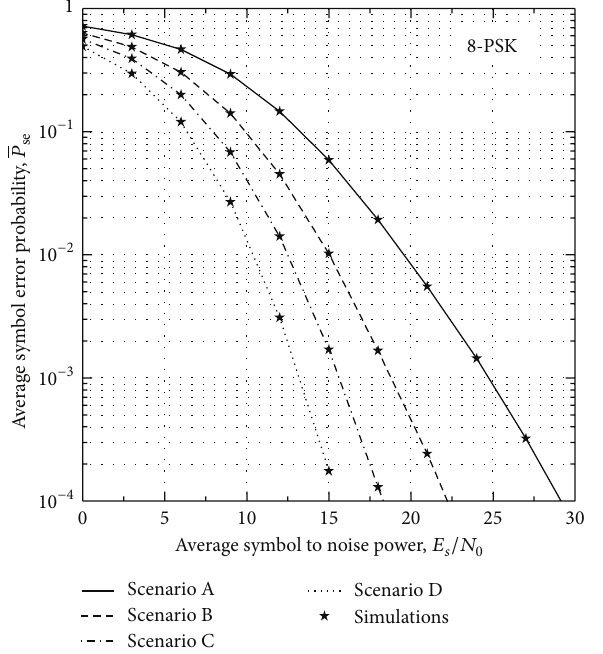
, of 16 -PSK of dual- se